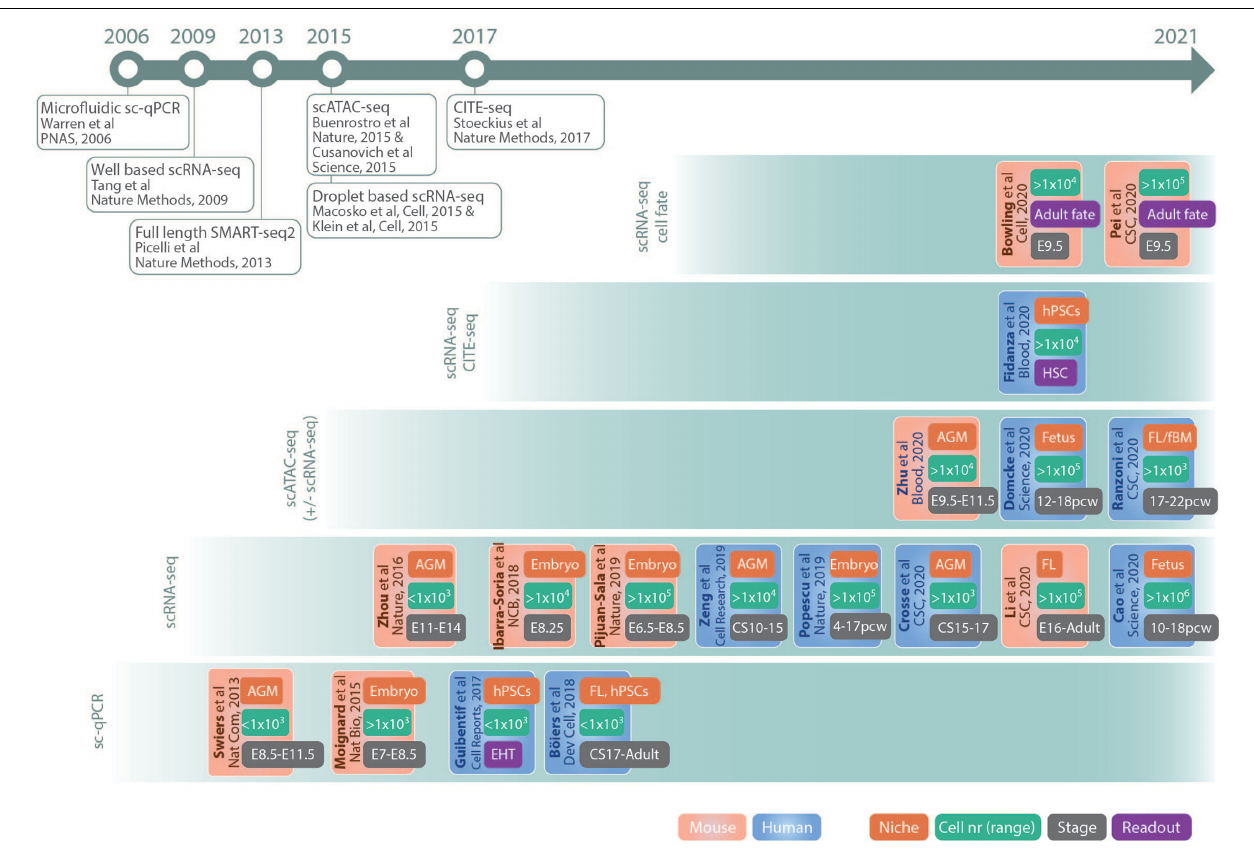
FIGURE 2 | Schematic drawing of key studies highlighted in the text. The references are grouped in panels according to the main method used and listed according to publication date. The color code of the boxes indicates if the study was performed in mouse ( red ) or human ( blue ). The different tags in the boxes indicates main fetal origin of cells investigated ( niche , red ), nr of cells sequenced ( cell nr , green ), approximate developmental age ( stage , gray ), and readout ( purple ). Publications of important single-cell methods are listed in the timeline at the top. AGM, aorta–gonad–mesonephros; fBM, fetal bone marrow; CS, Carnegie stage; E, embryonic day; EHT, endothelial to hematopoietic transition; FL, fetal liver; hPSCs, human pluripotent stem cells; pcw, postconceptual weeks; HSCs, hematopoietic stem cells. Abbreviations Journals: CSC, Cell Stem Cell; Dev Cell, Developmental Cell; NCB, Nature Cell Biology; Nat Bio, Nature Biotechnology; Nat Com, Nature